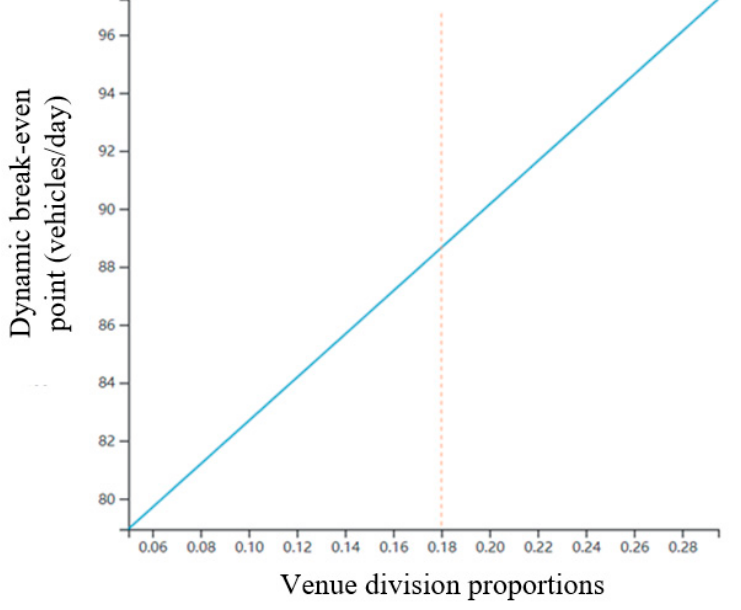
Figure 10. Sensitivity analysis of site division.